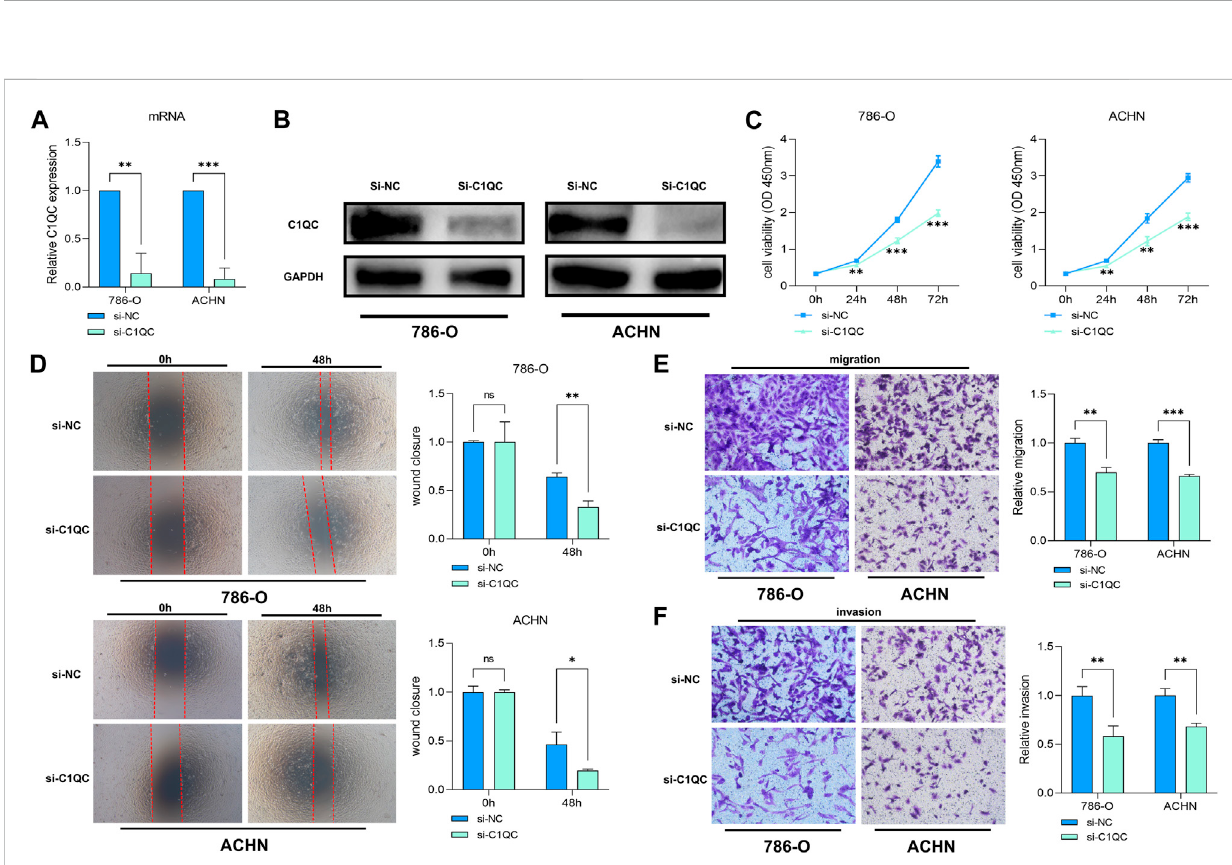
FIGURE 3 C1QC knockdown inhibits KIRC cell development. (A, B) The ef fi ciency of C1QC knockdown is evaluated by qRT-PCR and Western blotting assay. (C) C1QCknockdowninhibitsKIRCcellproliferation. (D) WoundhealingassayofC1QCknockdown. (E) C1QCknockdowninhibitsKIRCcellmigration.